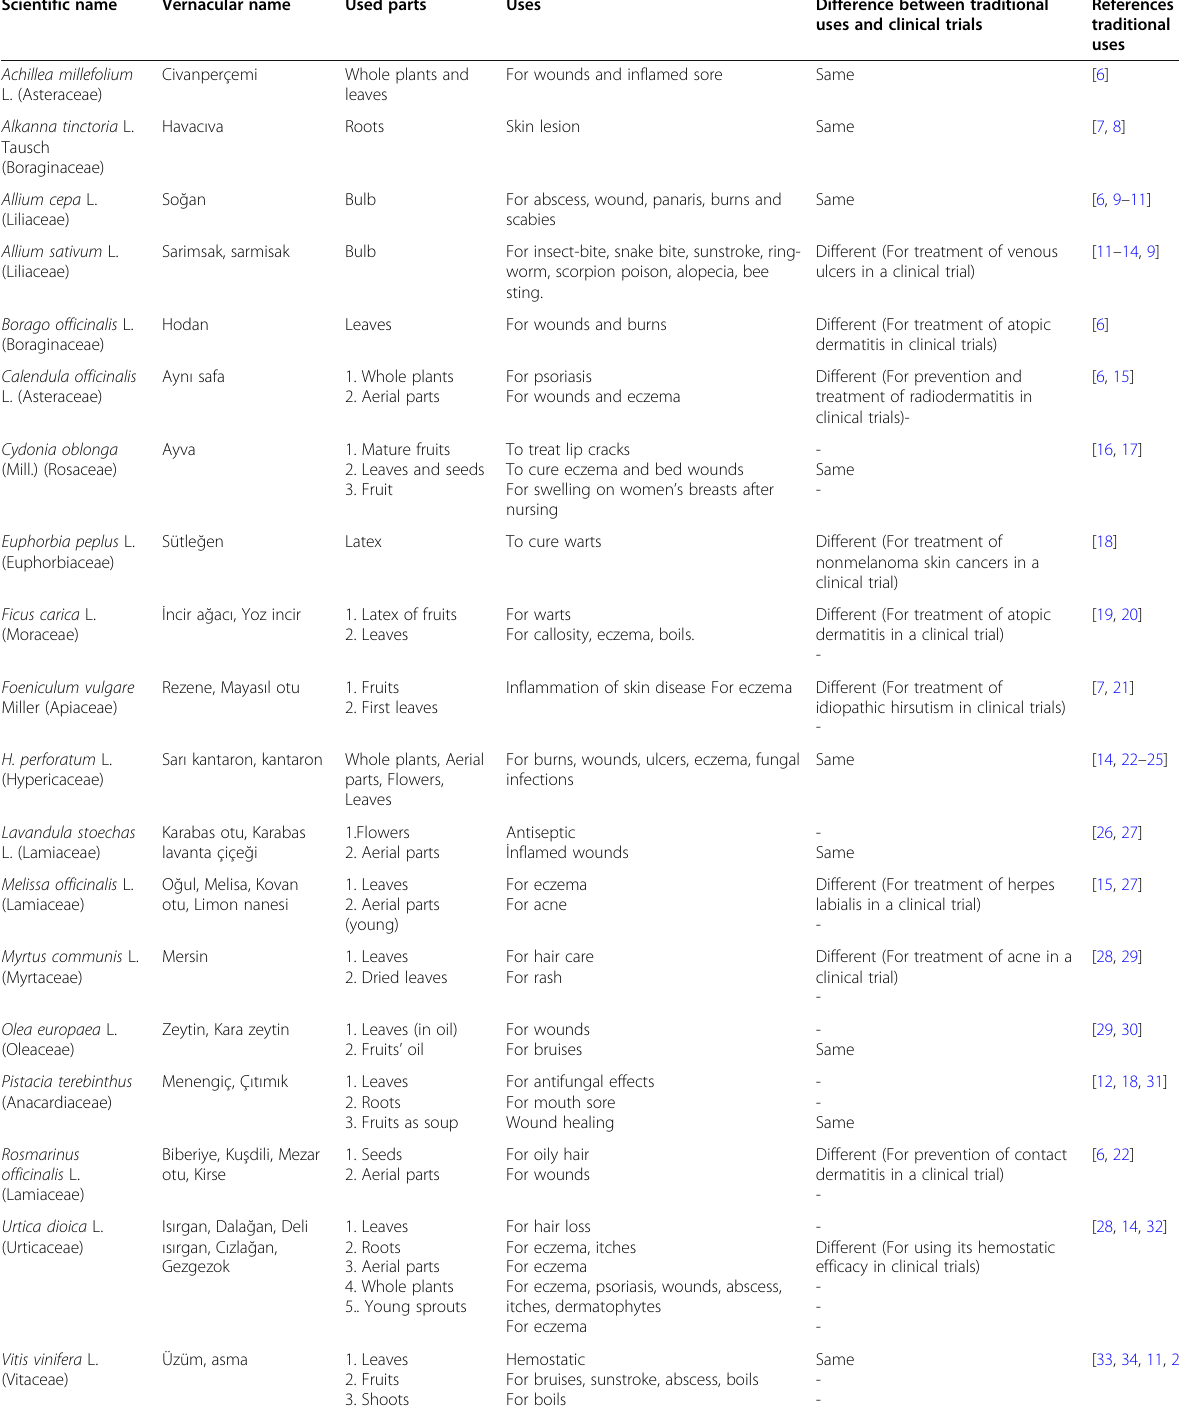
Table 3 Traditional uses of the plants for skin problems in